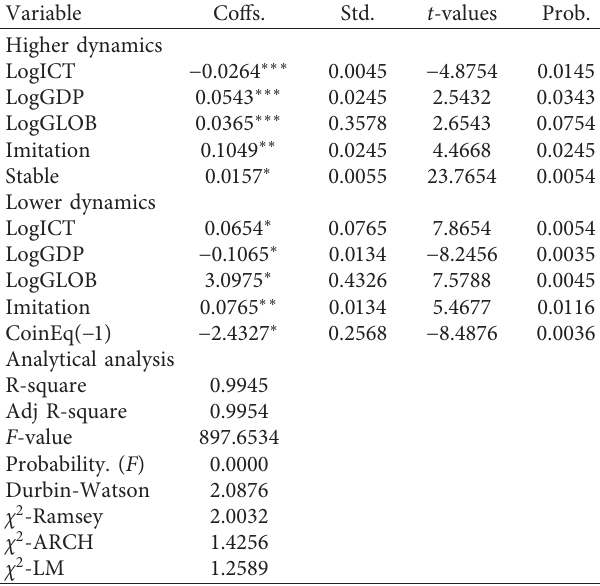
Table 4: Projected outcomes of long versus short